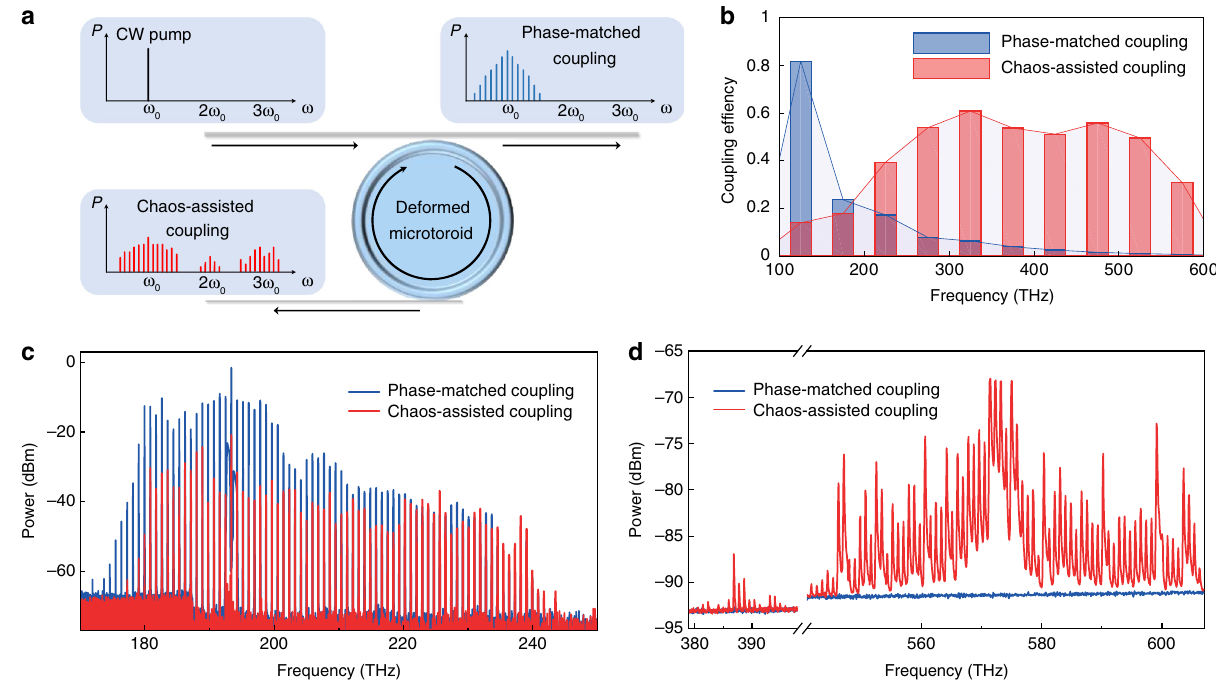
Fig. 4 Comparison between chaos-assisted coupling combs and phase-matched coupling combs. a Conceptual schematic: a phase-matched micro fi ber is used to couple pump laser into the deformed cavity and it also collects comb emissions at the through port. A nano fi ber is used at the drop port to output comb light through chaos-assisted coupling. b Three-dimensional fi nite difference time-domain (3D FDTD) simulation of the coupling ef fi ciencies of both phase-matched coupling and chaos-assisted coupling. c , d Optical spectra of the frequency combs with phase-matched coupling (blue) and chaos-assisted coupling (red) in infrared ( c ) and visible ( d ) regions.